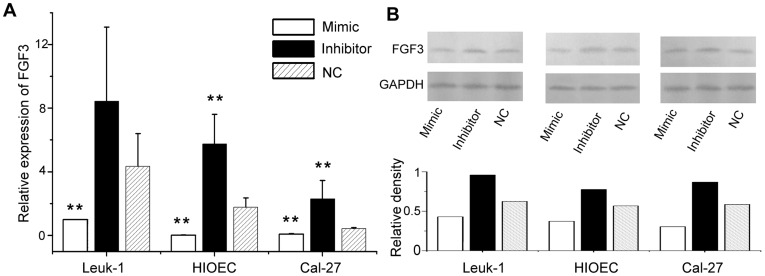
miR-31* mimics/inhibitors regulating mRNA and protein expression of FGF3 in oral cells.(A) QRT-PCR analysis of FGF3 expression in Leuk-1, HIOEC and Cal-27 cell lines, **p<0.05; (B) Western blot analysis of of FGF3 expression in Leuk-1, HIOEC and Cal-27 cell lines transfected with miR-31* mimic, miR-31* inhibitor and negative control. The representative blot is shown (upper for FGF3). The histogram shows the average volume density normalized by the loading control, GAPDH (lower).